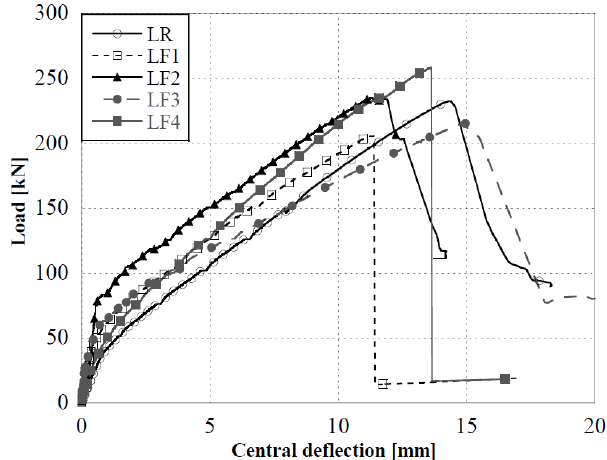
Figure 11. Load-deflection response of all test specimens.